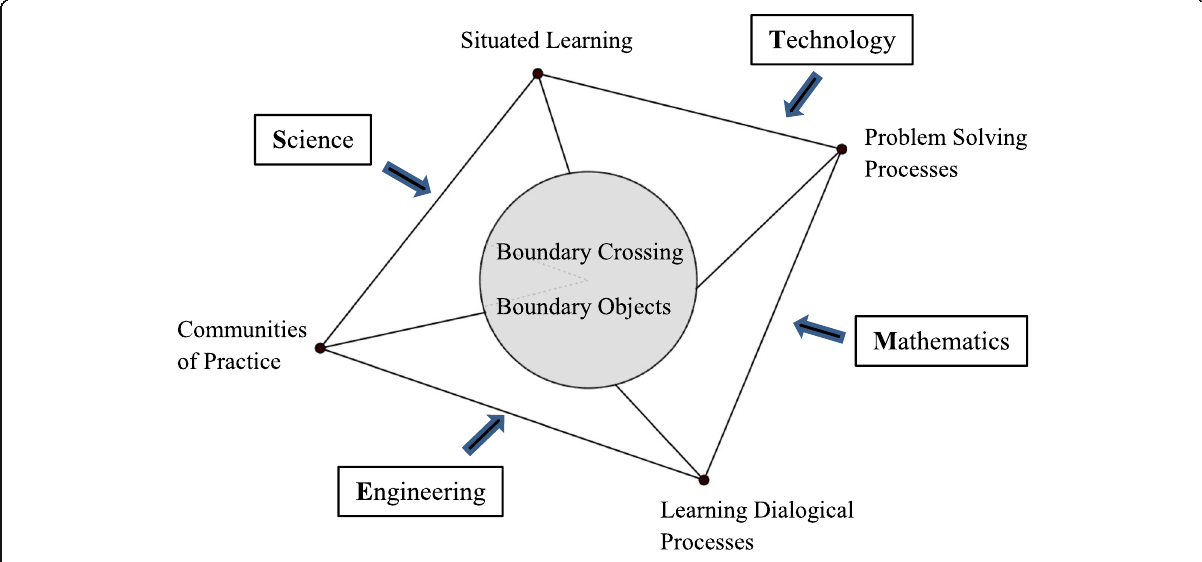
Fig. 1 An interactive framework for STEM